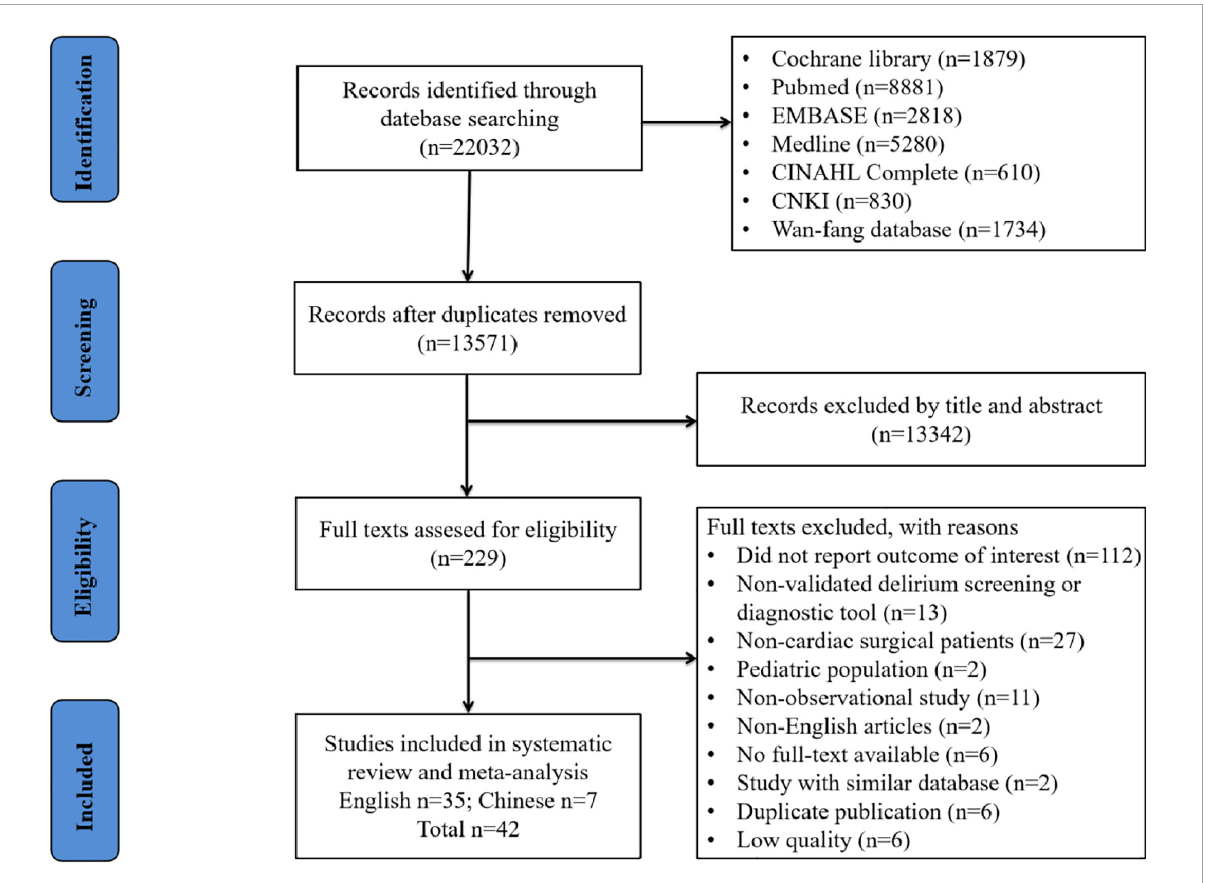
FIGURE1 Flow diagram to identify studies reporting the outcome of postoperative delirium in patients undergoing cardiac